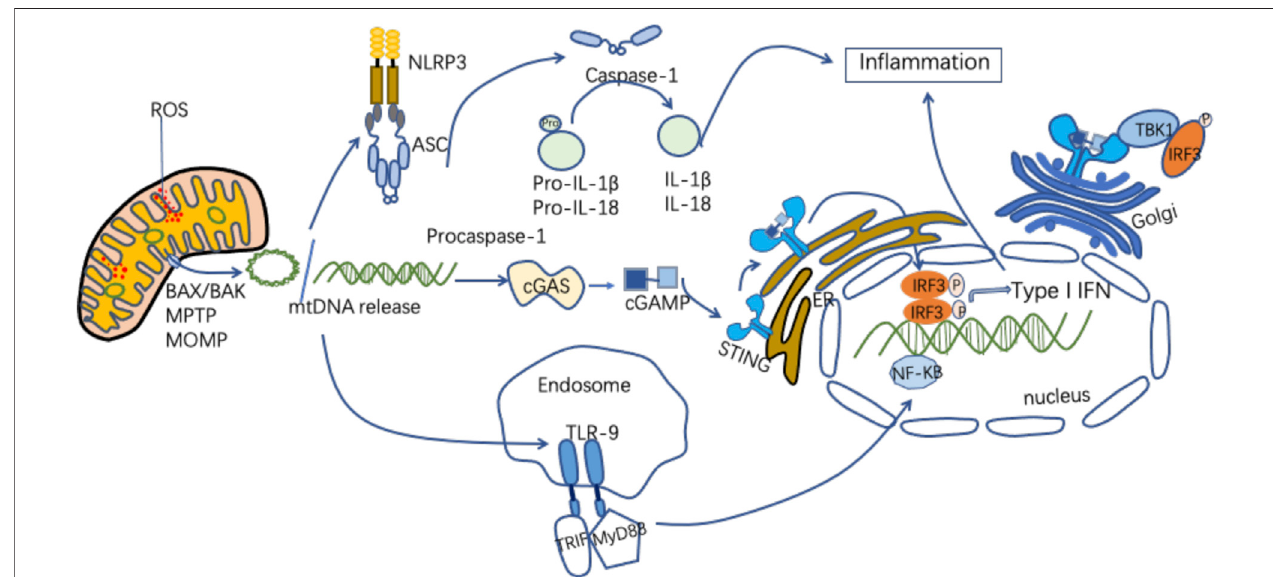
FIGURE 2 | Mechanisms of released mtDNA activation of in fl ammation. MtDNA can be released as circular molecules or DNA fragments when mitochondria are damagedorstressed.MtDNAreleasecanbemediatedthroughthemPTP,theMOMP,andtheapoptosis-associatedproteinBAX/BAK.ThereleasedmtDNAisinvolved in the in fl ammatory response through a variety of signaling pathways. MtDNA binds to NLRP3, activating the NLRP3 in fl ammasomes, which induces caspase-1 activation, causing the maturation and secretion of pro-in fl ammatory cytokines and participating in the in fl ammatory response. MtDNA binds to cGAS to form cGMP-AMP (cGAMP), which activates STING, and the activated STING recruits and activates TBK1. This leads to IRF3, NF-KB phosphorylation and nuclear translocation, promoting increased expression of interferon and in fl ammatory genes. MtDNA binds to TLR9, promoting MyD88 pathway activation and participating in in fl ammatory cytokine